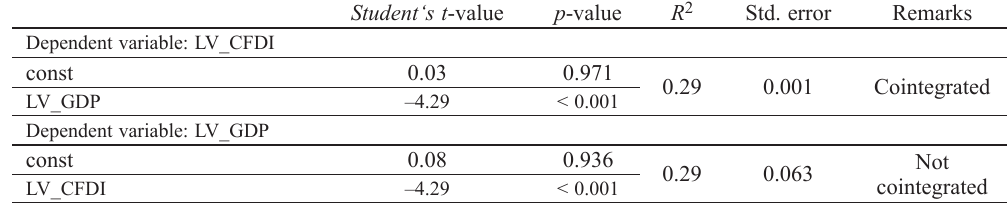
Table 6. Results of EG cointegration tests for Latvia Student‘s t -value Std.